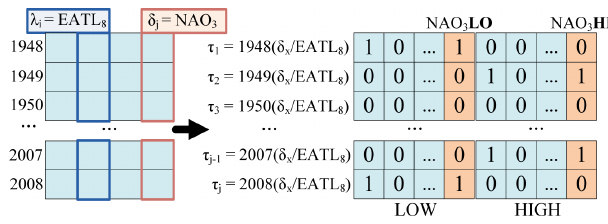
Figure 5. Data coupling for λ i = EATL 8 and δ j = NAO 3 .